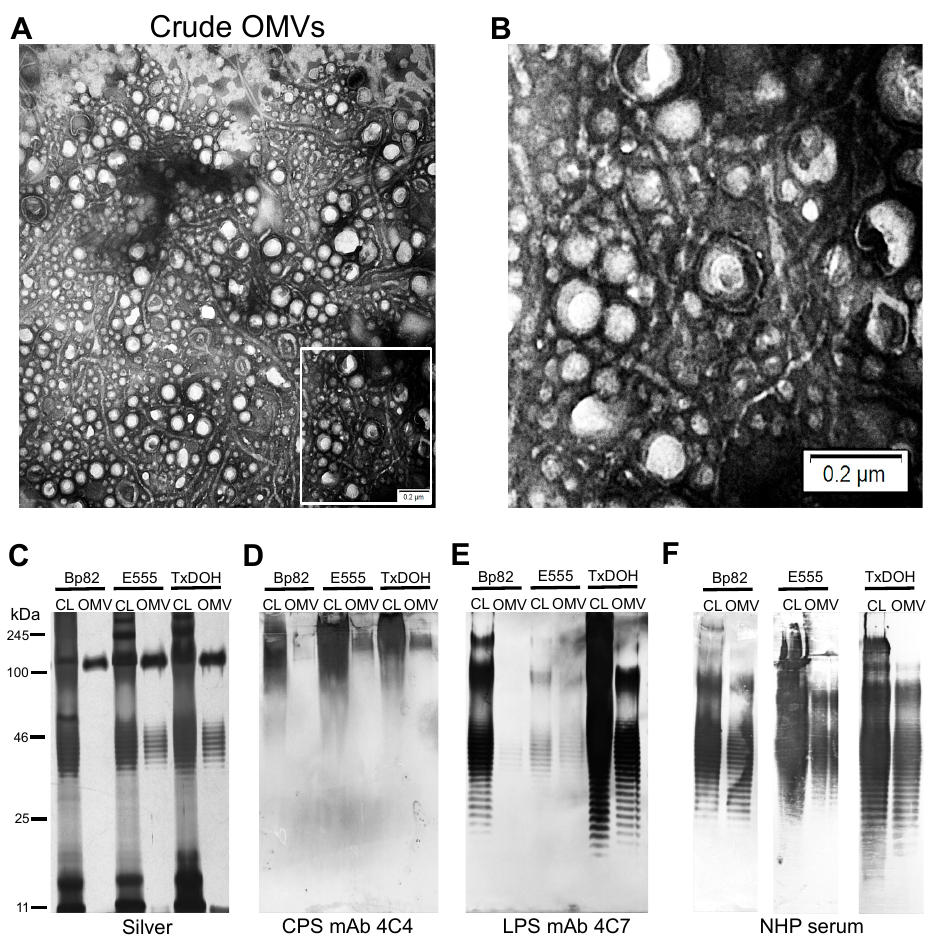
Figure 1. Analysis of outer membrane vesicles (OMVs) and immunogenic polysaccharides. ( A ) Crude OMV negative stained TEM image showing numerous vesicles and flagellar material. ( B ) Zoom image of crude OMV from the area indicated by the white box in ( A ). ( C ) Silver stain of polysaccharide preparations from cell lysates (CL) and OMVs. ( D ) Western blot of the major B. mallei capsular polysaccharide (CPS) reveals the high molecular weight polysaccharide is present in all three biosafe strains and their OMVs. ( E ) Western blot of the LPS O-antigen from all three biosafe strains and their OMVs using B. mallei O-antigen specific mAb 4C7. ( F ) Reactivity of non-human primate (NHP) serum with cell lysate and OMVs from all three biosafe strains. Further refinement of the association between CPS and the B. thailandensis OMV membranes was accomplished by TEM immunogold labeling of CPS using the CPS-specific mAb 4C4 as primary